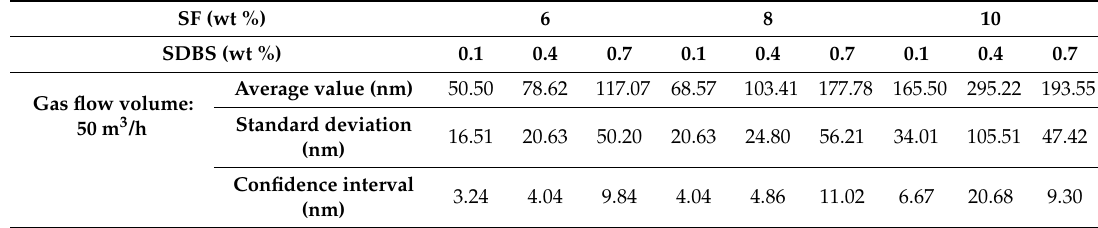
Table 3. Effects of SF concentration and SDBS content on the average diameter of SF nanofibers when the gas flow volume was 50 m 3 /h.